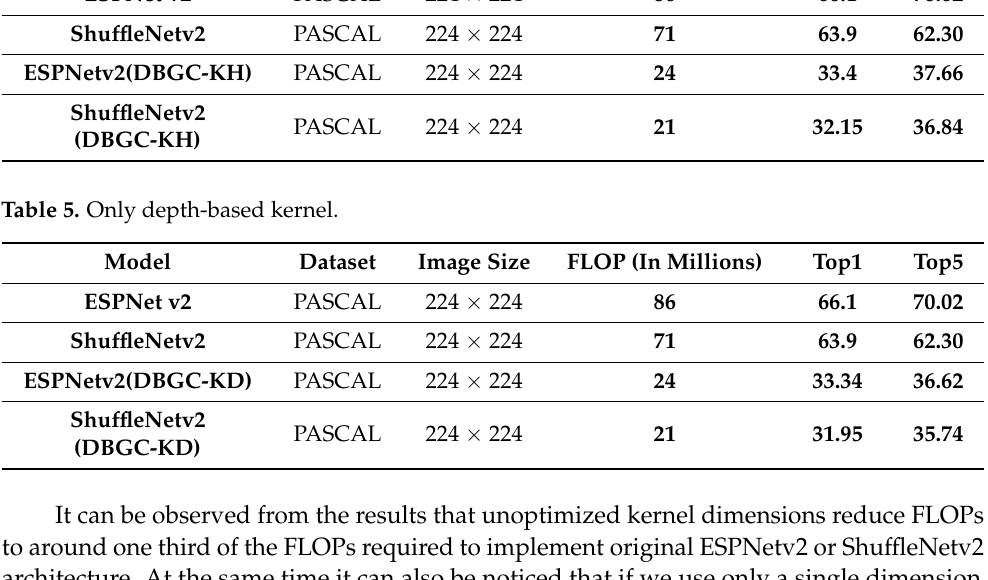
Table 4. Only height-based kernel.